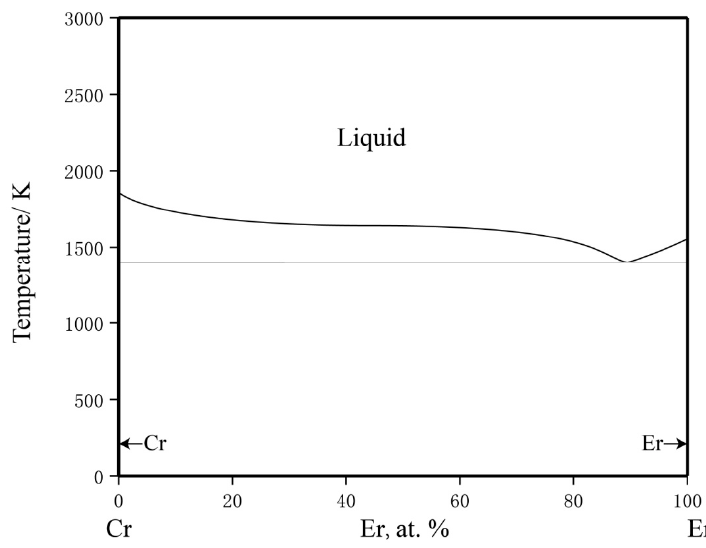
Figure 3. The calculated Cr–Er phase diagram based on the work of Ray et al. [43].